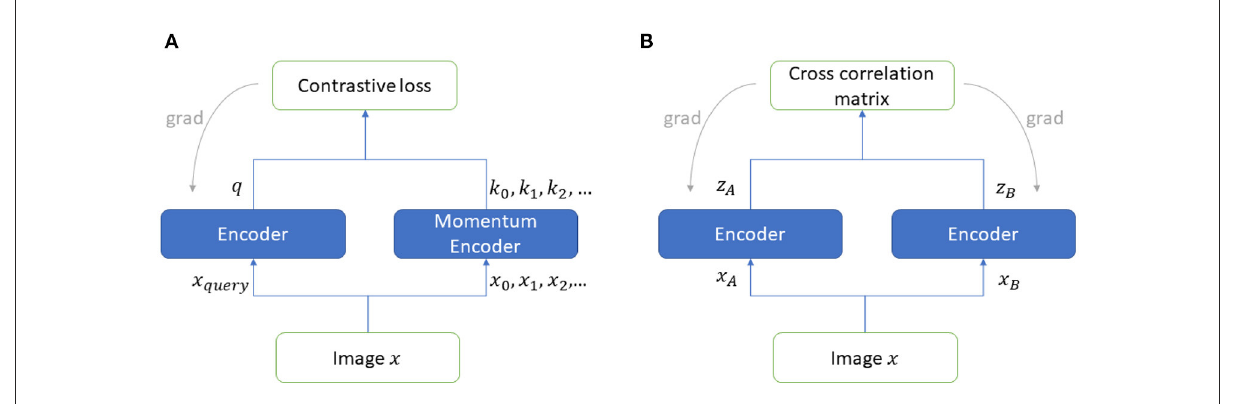
FIGURE5 Self-supervised frameworks (A) MoCoV2, (B) Barlow